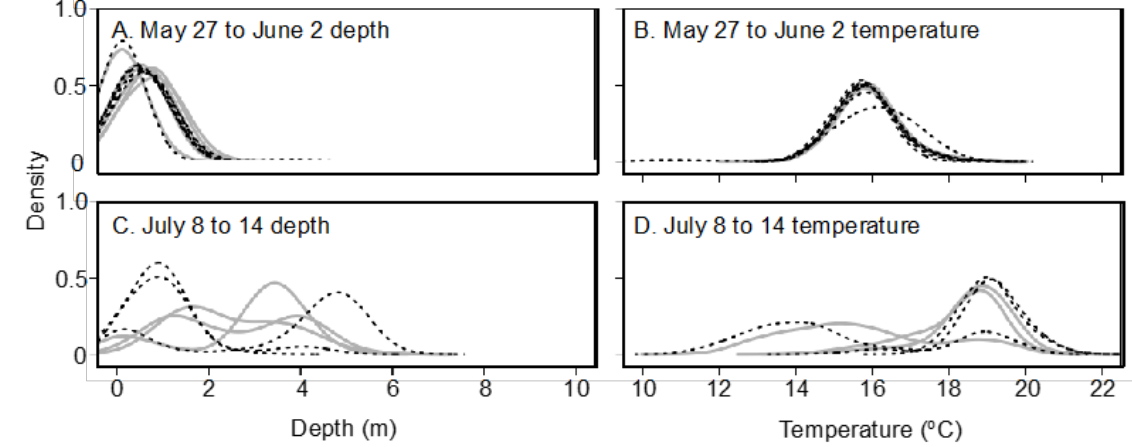
Figure 4. Kernel density plots of telemetry (Vemco VP TP transmitters) water depths ( A , C ) and temperature ( B , D ) logs for Blackwater rainbow trout ( Oncorhynchus mykiss ) in Bluey Pothole 2 in 2008. Gray lines represent diploid (2N) trout and dotted black lines represent triploid (3N) trout from 27 May to 1 June ( A , B ) and 8 to 14 July ( C , D ). From 27 May to 2 June, n was 11 for 2N and 7 for 3N. From 8 to 14 July, n was 4 for 2N and 1 for 3N.